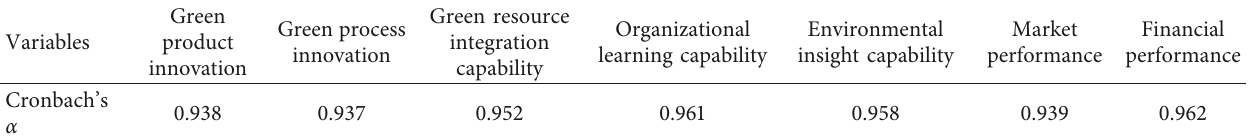
Table 4: Cronbach’ α